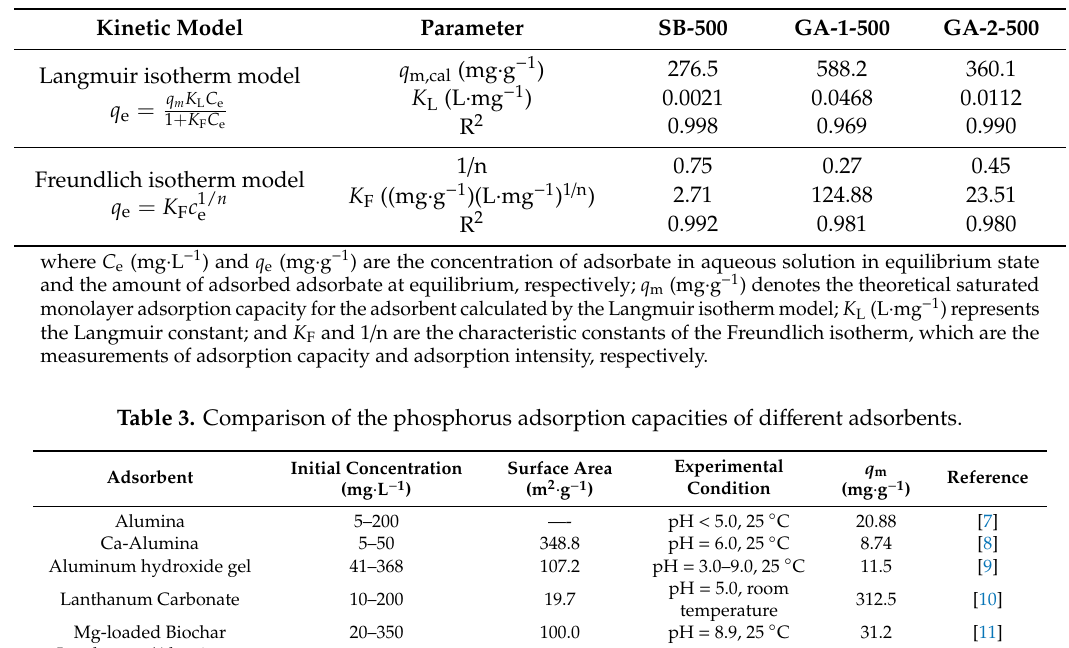
Figure 8. Adsorption isotherm behaviors for different initial concentrations of phosphorus solution. Table 2. Adsorption isotherm constants for phosphorus removal by alumina adsorbents. Table 3. Comparison of the phosphorus adsorption capacities of different adsorbents.